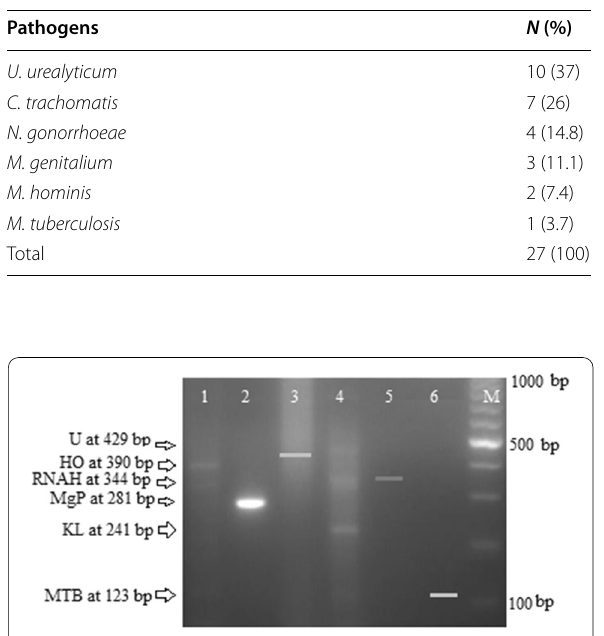
Table 3 Detection of urogenital pathogens from sterile pyuria by PCR